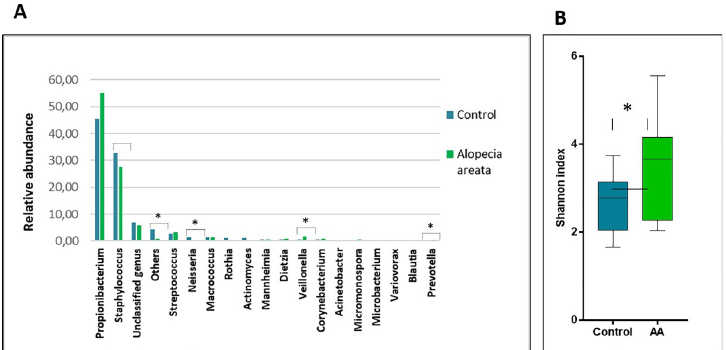
Fig 1. Bacterial profiling in control and AA subjects. (A) % of bacteria at genus level in the control and AA groups. Results are presented as the percentage (%) of total sequences, ( � p � 0.05). (B) Shannon diversity index for bacterial population observed in control and AA subjects ( � p � 0.05).